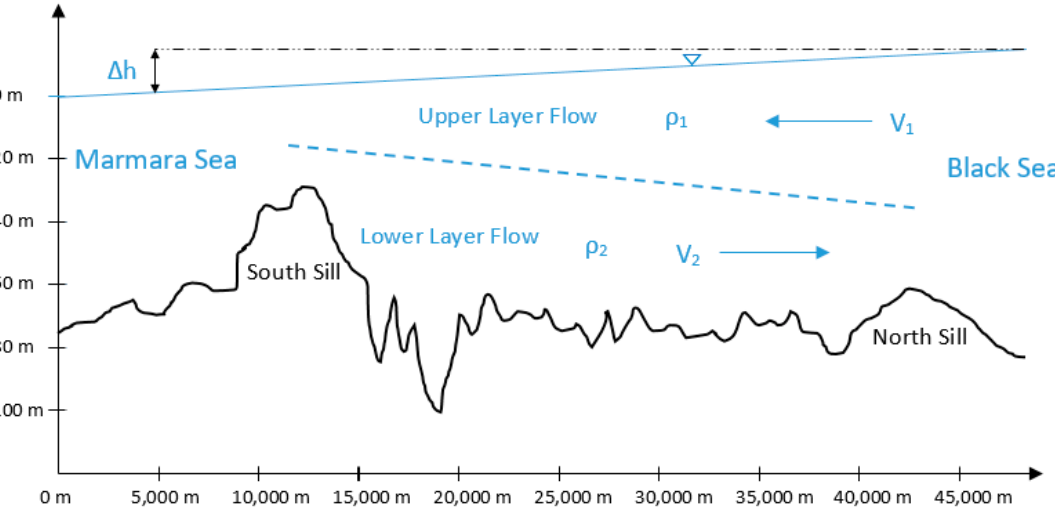
Figure 2. Schematic description of the longitudinal section of the Istanbul Strait based on [2].